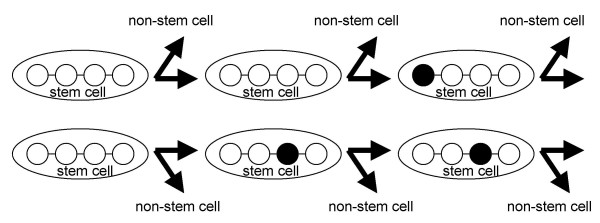
Somatic cell inheritance of methylation patterns. The tags used in this study are unmethylated at birth (unmethylated CpG sites represented by open circles, with filled circles representing methylated sites). Generally the same methylation pattern is faithfully copied and passed on to daughter cells. However, random epigenetic errors may occur, and these errors are also subsequently inherited. Methylation patterns (5' to 3' order of methylation) potentially encode numbers of divisions since birth and ancestral relationships between cells. Of note, new errors in non-stem cells will be lost during normal crypt differentiation, migration and death.